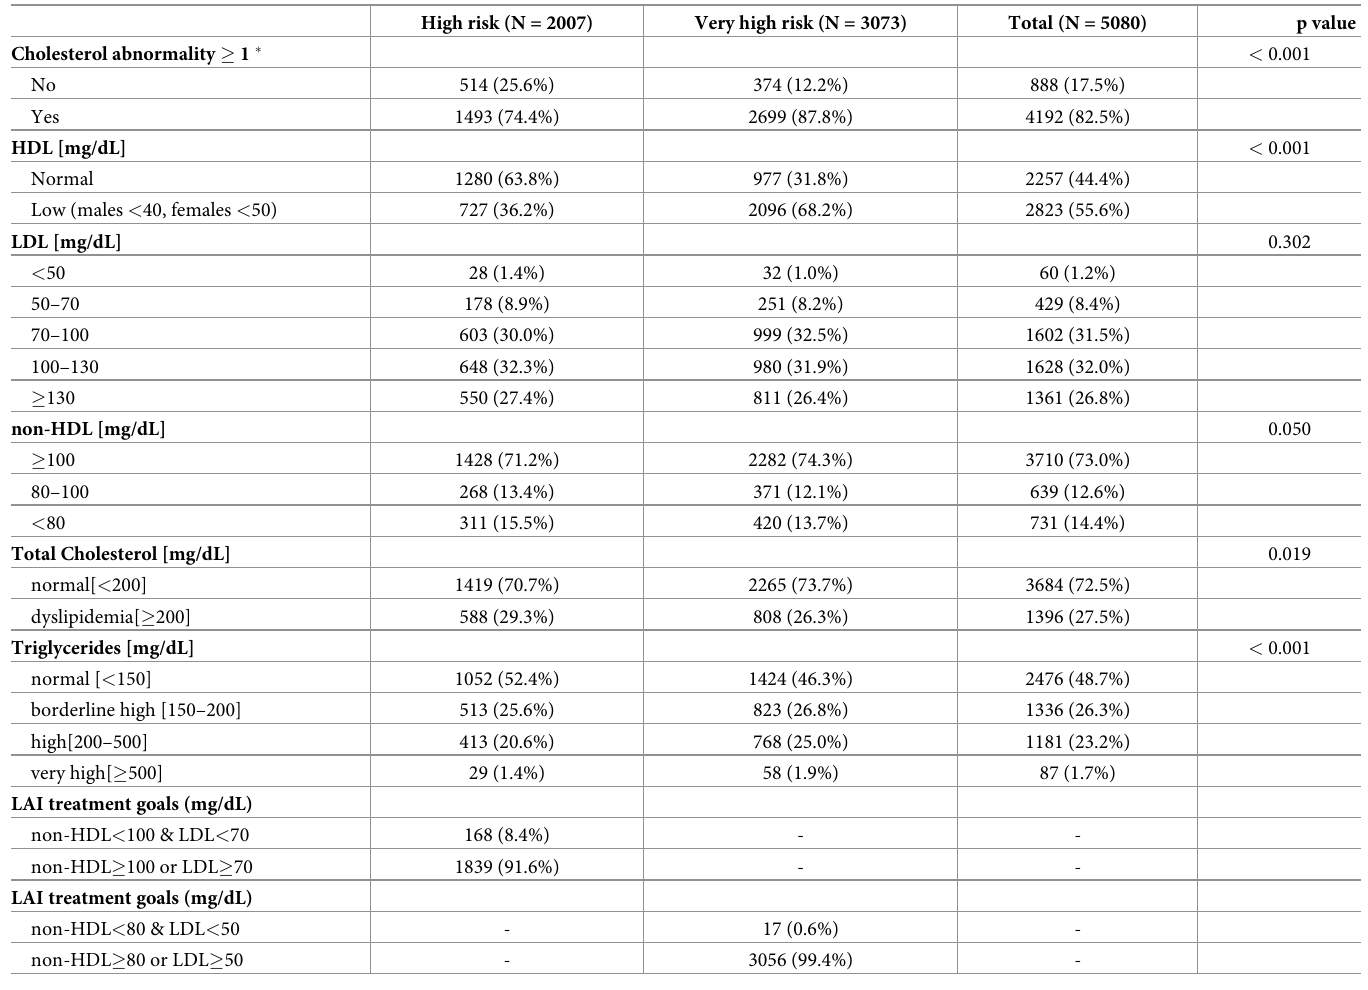
Table 2. Lipid parameters separated for LAI risk